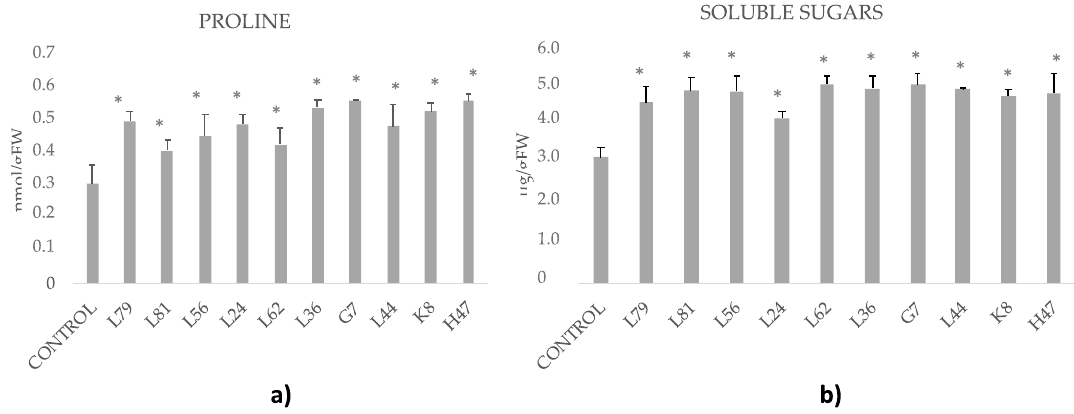
Figure 6. ( a ) Proline (nmol/g fresh weight) and ( b ) soluble sugars concentration (μmol/g fresh weight) measured in olive tree leaves treated with the ten strains. Average values of the replicates with standard error bars are represented ( n = 6). Asterisks (*) represent significant differences with the control according to the LSD test ( p < 0.05).